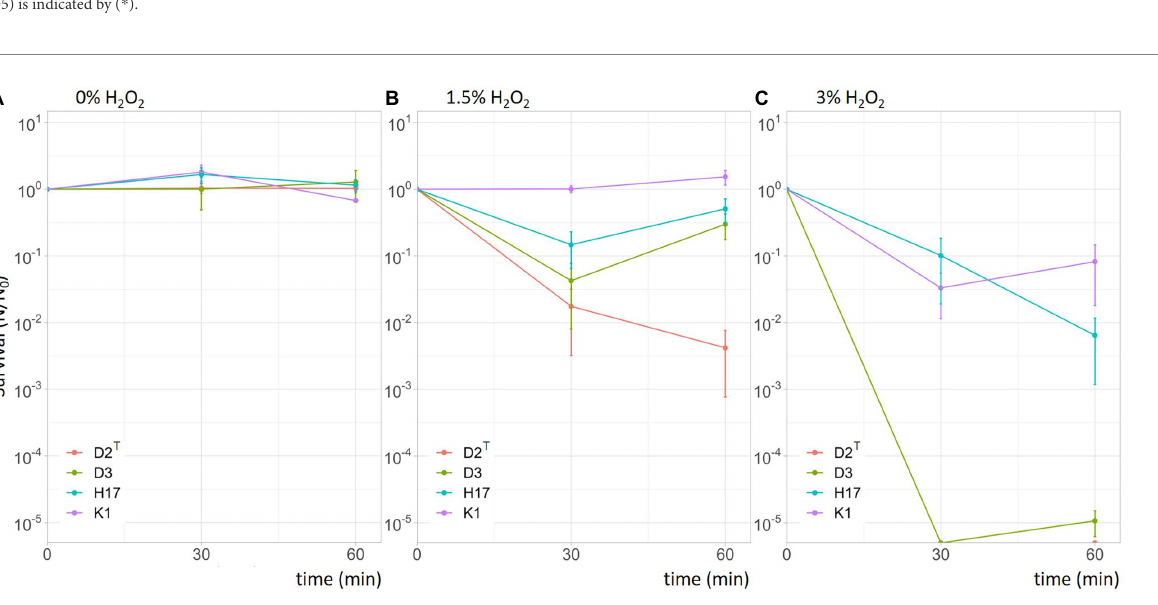
FIGURE 7 Survival of S. capitis strains in 0% (A) , 1.5% (B) and 3% (C) hydrogen peroxide for 30- and 60-min. Experiment was performed with an initial OD 600nm of 0.3 resulting in initial cell counts (0 min) of 10 8 CFU/mL. The experiment was performed in three biological replicates. Error bars represent the calculated standard error.